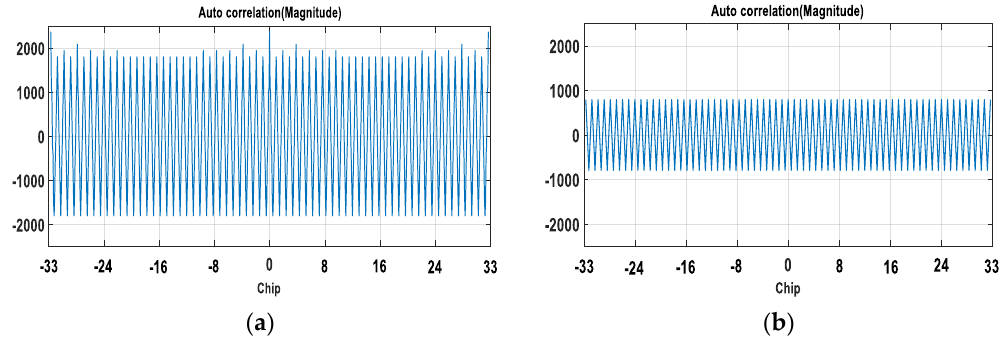
√ 3 SC P ( t ) ; ( b ) SC D ( t ) .